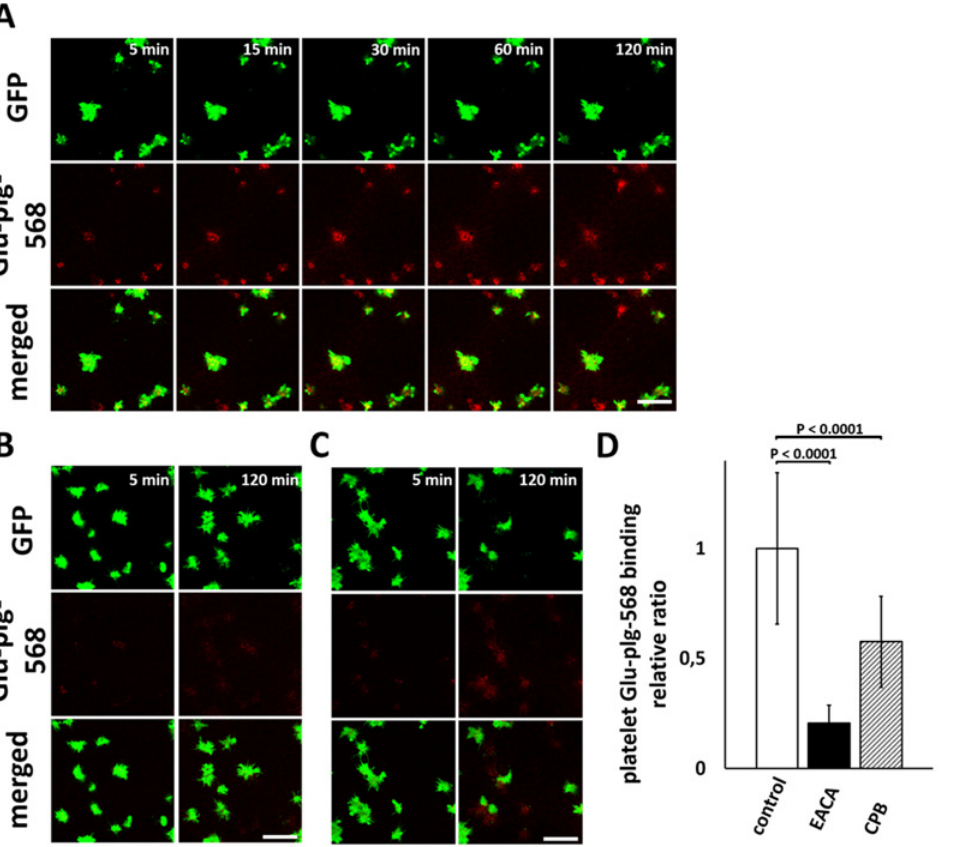
Fig 5. Time-dependent accumulation of Glu-plg-568 on the platelet surfaces from GFP-mice incorporated into the fibrin network. Diluted PRP from GFP-mice was treated with thrombin (1 U/ml) in the presence of Glu-plg-568, and accumulation of Glu-plg-568 on the surface of platelets incorporated into the fibrin network was monitored over time by CLSM, either in the absence (A) or in the presence (B) of 100 mM of EACA or 15 U/ml CPB (C). Representative CLSM images were obtained 3 μ m from the bottom of the dish at the indicated time points after addition of thrombin (1 U/ml). Fibrin network formation and the incorporation of platelets in the network were clearly demonstrated after addition of thrombin, which was followed by accumulation of Glu-plg-568 on the surface of platelets even prior to the decrease in GFP fluorescence intensity. Binding of Glu-plg-568 was significantly inhibited in the presence of EACA and CPB. The scale bars represent 10 μ m. (D) The platelet Glu-plg-568 binding relative ratio was expressed as the integrated fluorescence intensity of Glu-plg- 568 bound to the surface of platelet 120 minutes after thrombin supplementation and divided by the area of the platelet (n = 30 activated platelets from three independent experiments in each column). This assay was analyzed with a t -test for independent samples. Results are normalized to the control sample mean value (mean ±